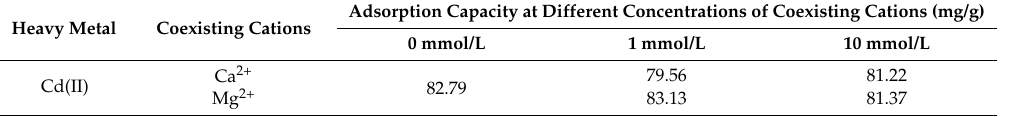
Table 4. Influence of cations on the adsorption of Cd(II) on Mn